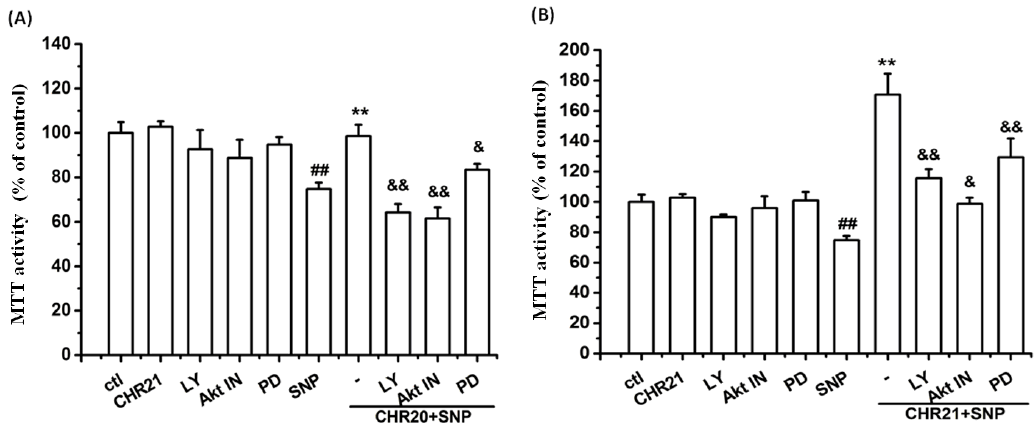
Figure 8. Cont. Figure 8. Cont